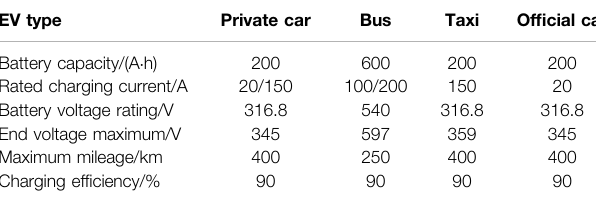
TABLE 2 | Parameter setting of the electric vehicle ’ s